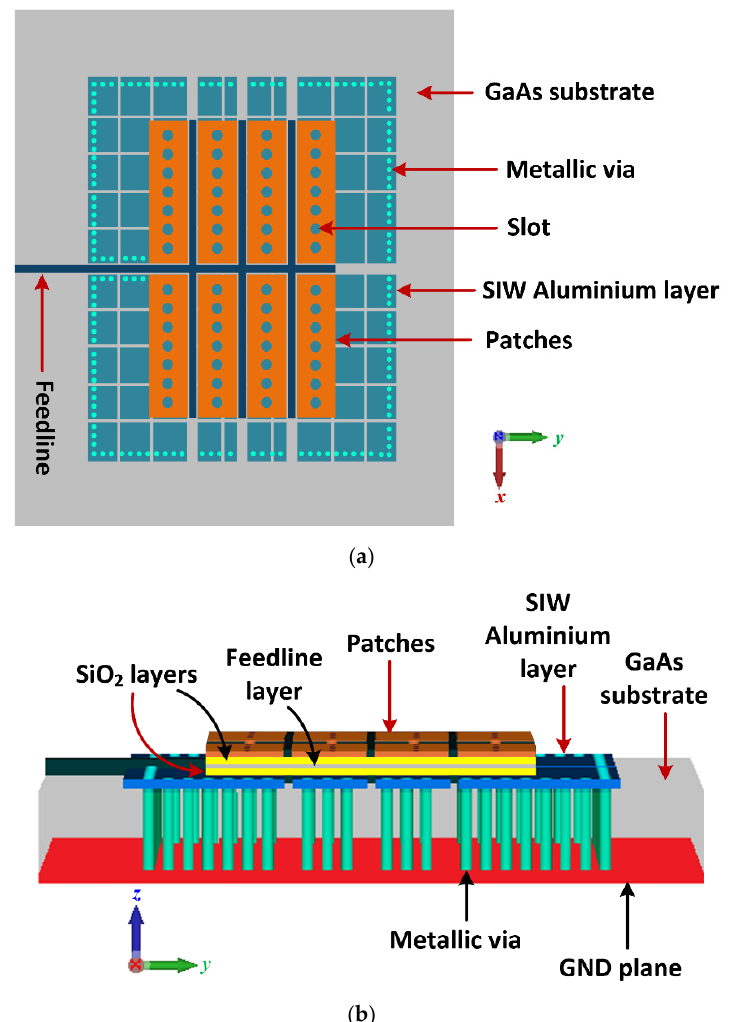
Figure 1. The proposed AoC incorporating metamaterial and SIW technologies, ( a ) top view, and ( b ) side view.